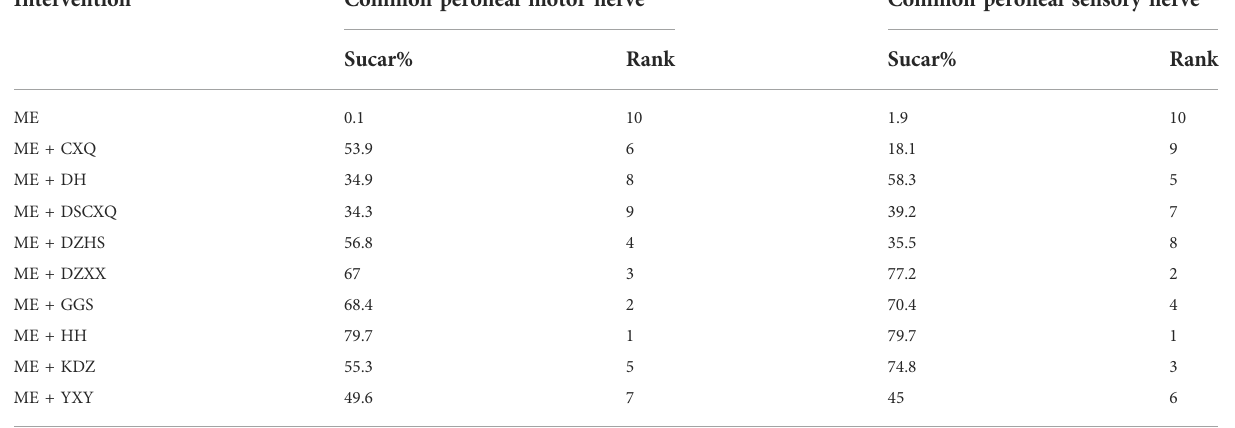
TABLE 7 The cumulative ranking probabilities (SUCRA) results of common peroneal nerve. Intervention Common peroneal motor nerve Common peroneal sensory